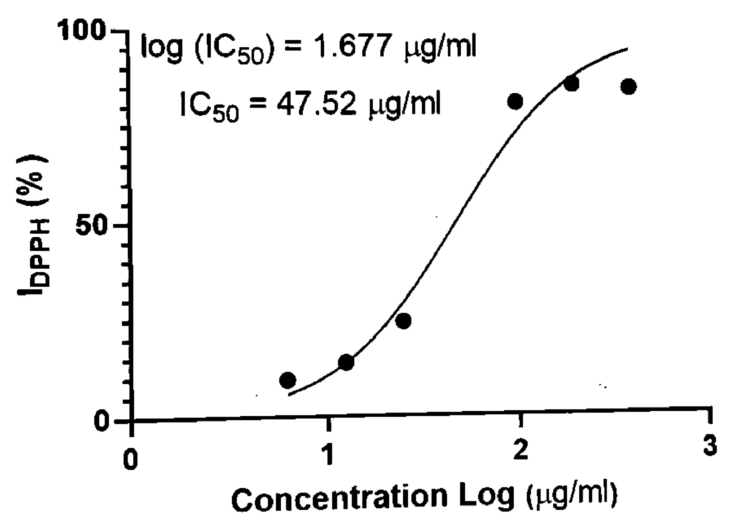
Figure 3. The logarithm-concentration response curve of the extract in the elimination or capture of free